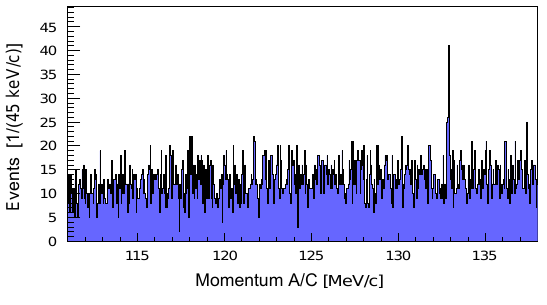
Figure 2. Momentum spectrum for strangeness tagged pions from the 2014 measurement at MAMI [14]. Mono-energetic decay-pions of 4 Λ H were observed at ∼ 133MeV / c . A signal from two- body decays of stopped 3 Λ H was not found at the expected momentum of ∼ 114MeV / c